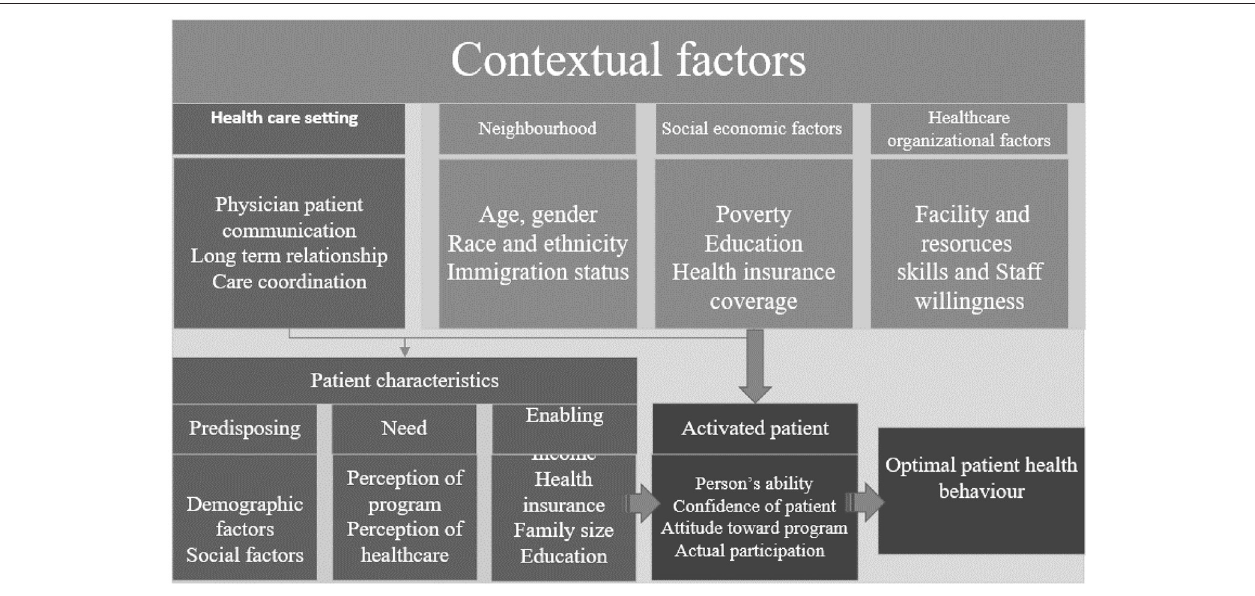
FIGURE 1 | Important contextual factors for Asthma educational programme (Developed by the